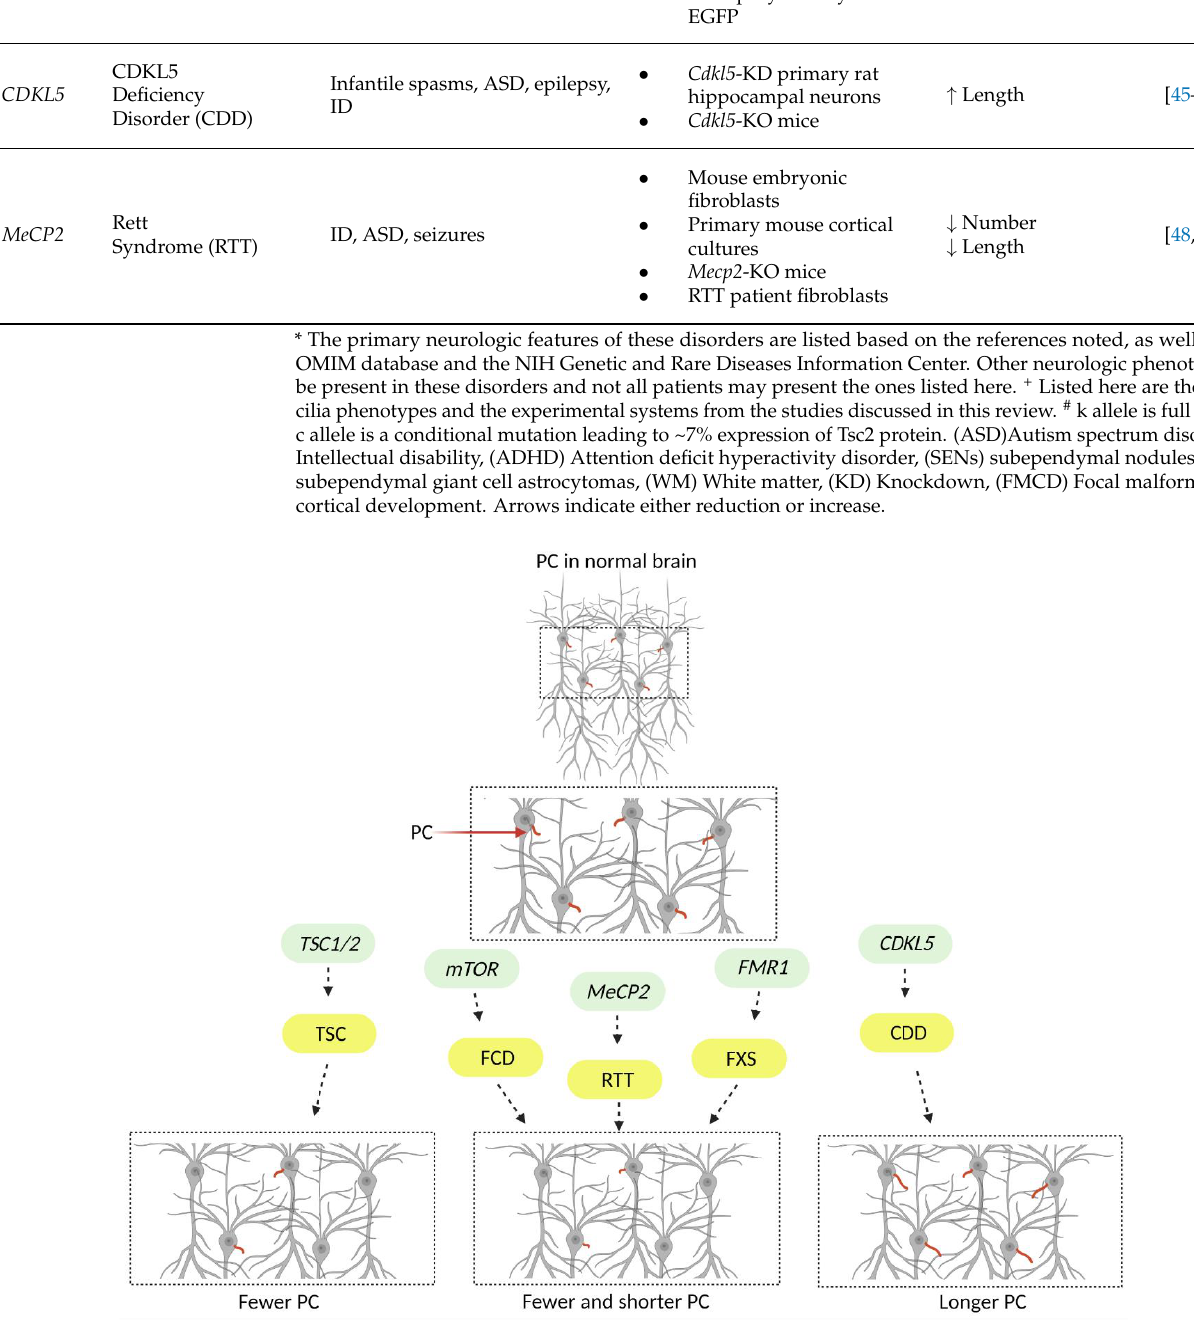
Figure 2. Primary cilia phenotypes in monogenic neurodevelopmental disorders. Mutations in genes (denoted in green) underly a group of neurodevelopmental disorders (denoted in yellow) that exhibit severe neurologic and neuropsychiatric manifestations including cortical malformation, ep- ilepsy, ASD, and ID. Some of the neurological phenotypes are unique to certain disorders while others are shared (see Table 1). Recently several studies discovered that these disorders exhibit neu- ronal primary cilia (colored red in the illustration) deficits raising the question of whether these organelles contribute to the neurologic manifestations that patients exhibit. (TSC) Tuberous sclerosis complex, (FCD) Focal cortical dysplasia, (RTT) Rett syndrome, (FXS) Fragile-X syndrome, (CDD) CDKL5 deficiency disorder, (ASD) Autism spectrum disorder, (ID) Intellectual disabilities. Created with BioRender.com (www.biorender.com, accessed on 2 December 2022). Table 1. Primary cilia phenotypes in neurodevelopmental disorders discussed in this review . Mutated Gene